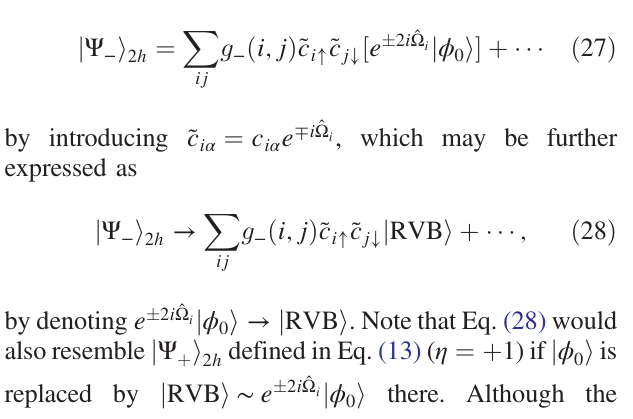
FIG. 10. The mutual duality shown by the Fourier trans- and S , of the gauge invariant vortex correlations formations, f k x k x f in Eq. (25) (red) and the spin-spin correlation h ϕ 0 j S jj 0 ϕ S 0 i (blue) along the x direction, which are measured j ¼ i þ x j on (a) the AFLRO state and (b) an RVB state in the dimer